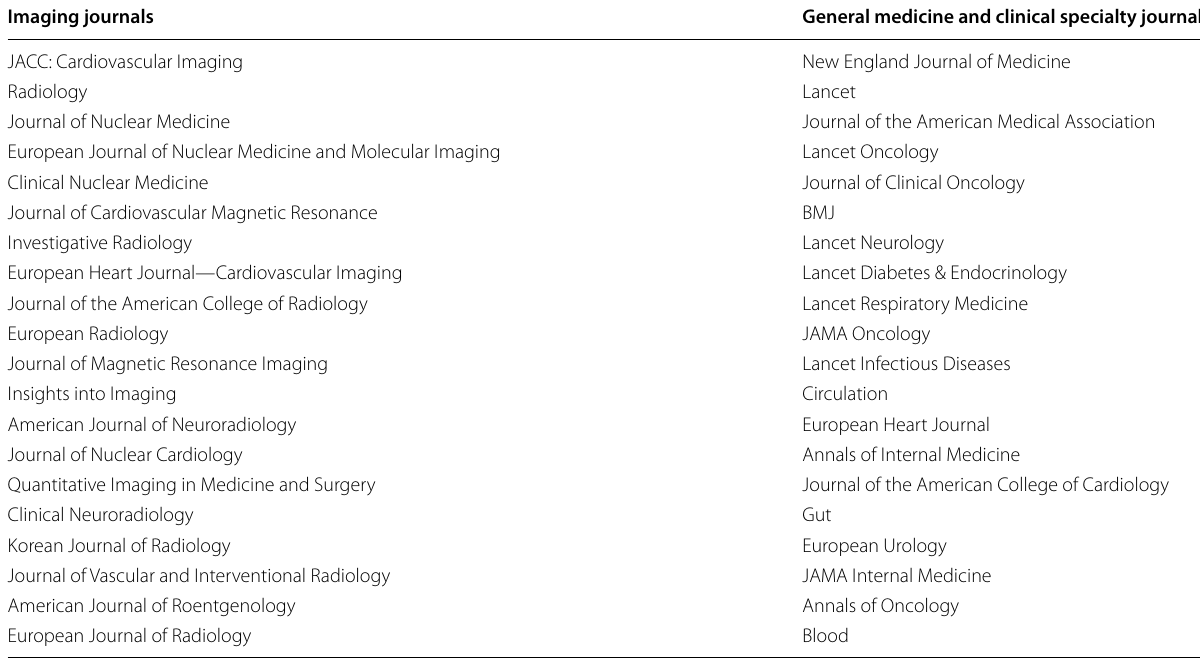
Table 1 Overview of 20 clinical imaging journals and 20 general medicine and clinical specialty journals whose studies were potentially eligible for